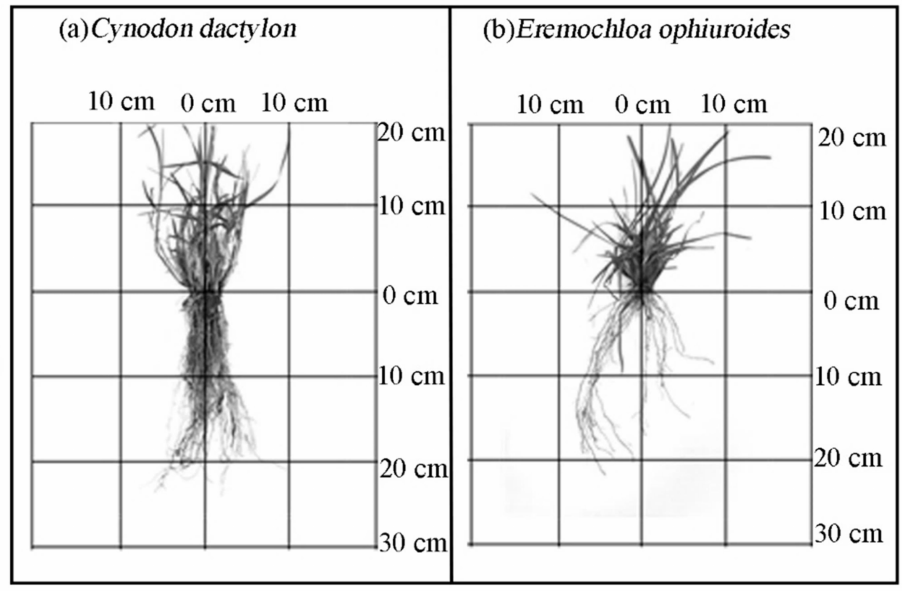
Figure 3. Morphology of 4-month-old C. dactylon ( a ) and E. ophiuroides ( b ) plants grown in crates. Table 1. Means ± SEs of root area ratios at various soil depths for C. dactylon and E. ophiuroides . Species